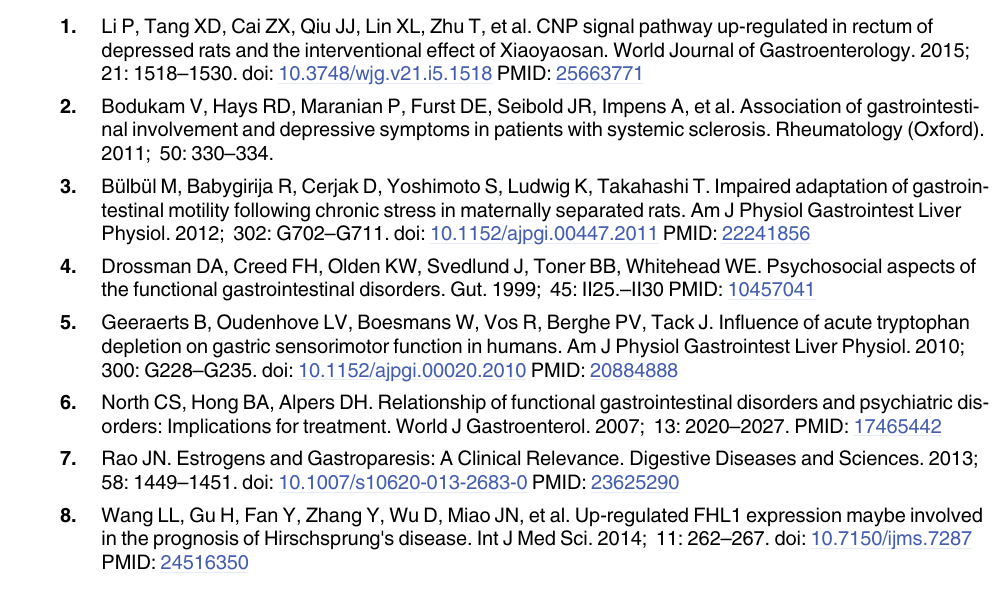
S1 Table. (A) The weight of rats (mean±SE). (B) Sucrose preference test(%). (C) The rate of gastric residual(%). S2 Table. (A) Open-field test(crossed-grids times). (B) Open-field test (standing times). (C) Open-field test (grooming times). S3 Table. Effects of cANF on A value of MTT of rat GSMCs